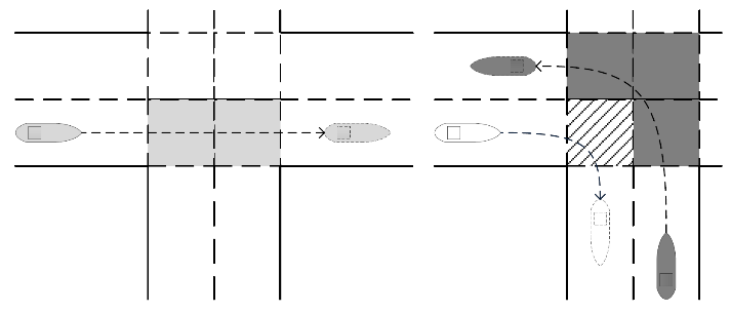
Figure 5. Spatial and temporal resource of waterway intersections.